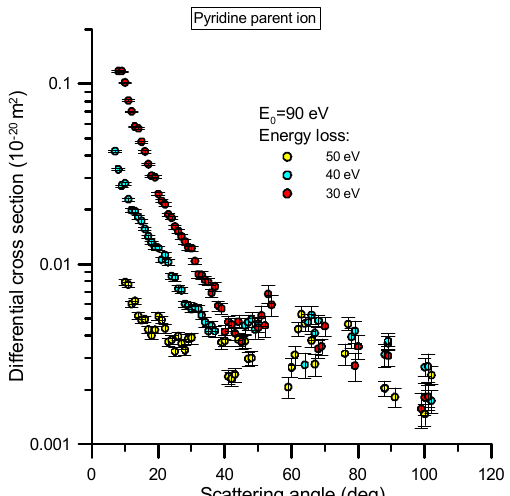
Figure 2. Double differential cross section for the production of the pyridine parent ion (C 5 H 5 N + ) under 90 eV electron impact ionization where the scattered electron has different energy loss values (30, 40 and 50 eV). See also the legend in the figure.